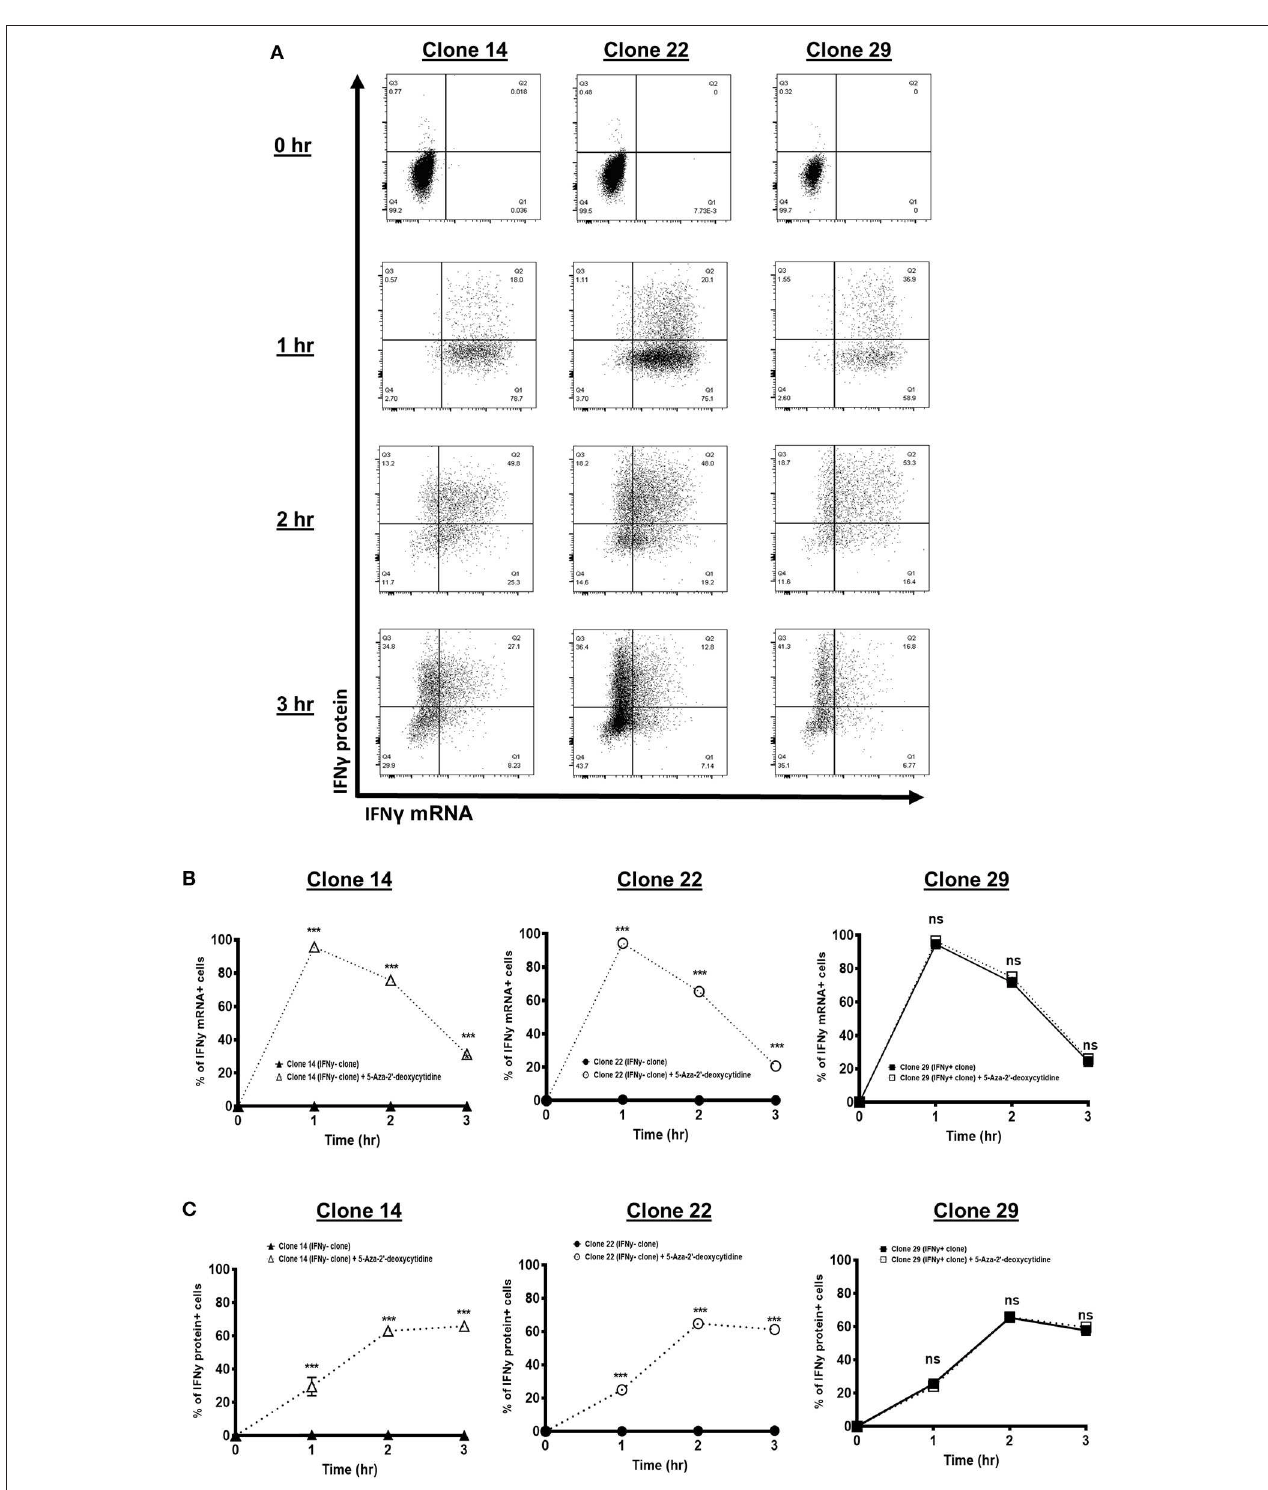
FIGURE 5 | Interferon gamma (IFN γ ) kinetics of synovial sarcoma X (SSX)-2-specific T cell clones following DNA demethylating agent treatment. (A) Flow cytometry dot plots of IFN γ mRNA and protein expression of two IFN γ − clones (Clones 14 and 22) and one IFN γ + clone (Clone 29), following treatment with DNA demethylating agent (5-aza-2 ′ -deoxycytidine) for 3 days prior to activation with CD3/CD28 activator antibody at the indicated time points. Proportion of cells with IFN γ mRNA (B) and protein (C) of two IFN γ − clones (Clones 14 and 22) and one IFN γ + clone (Clone 29), following 3 days’ treatment with or without 5-aza-2 ′ -deoxycytidine prior to co-culture with CD3/CD28 activator antibody at the indicated time points. N , number of experimental repeats = 3. Analysis performed with two-way ANOVA with Tukey’s multiple comparison.